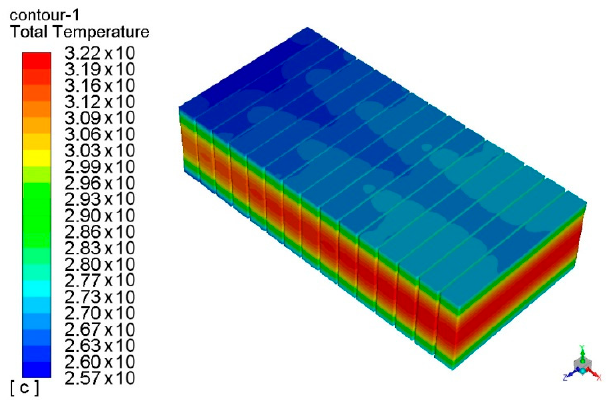
Figure 24. Battery surface temperature distribution with optimized geometry.